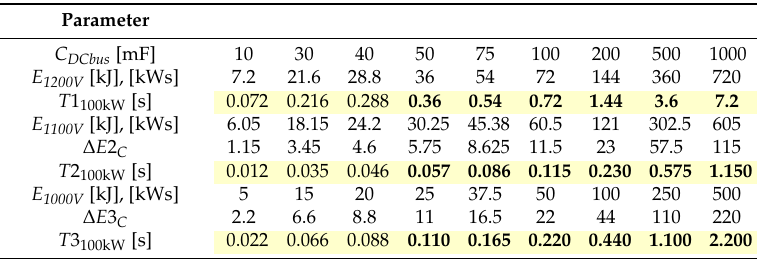
Table 1. Energy of the capacitor connected on the DC bus of SST.